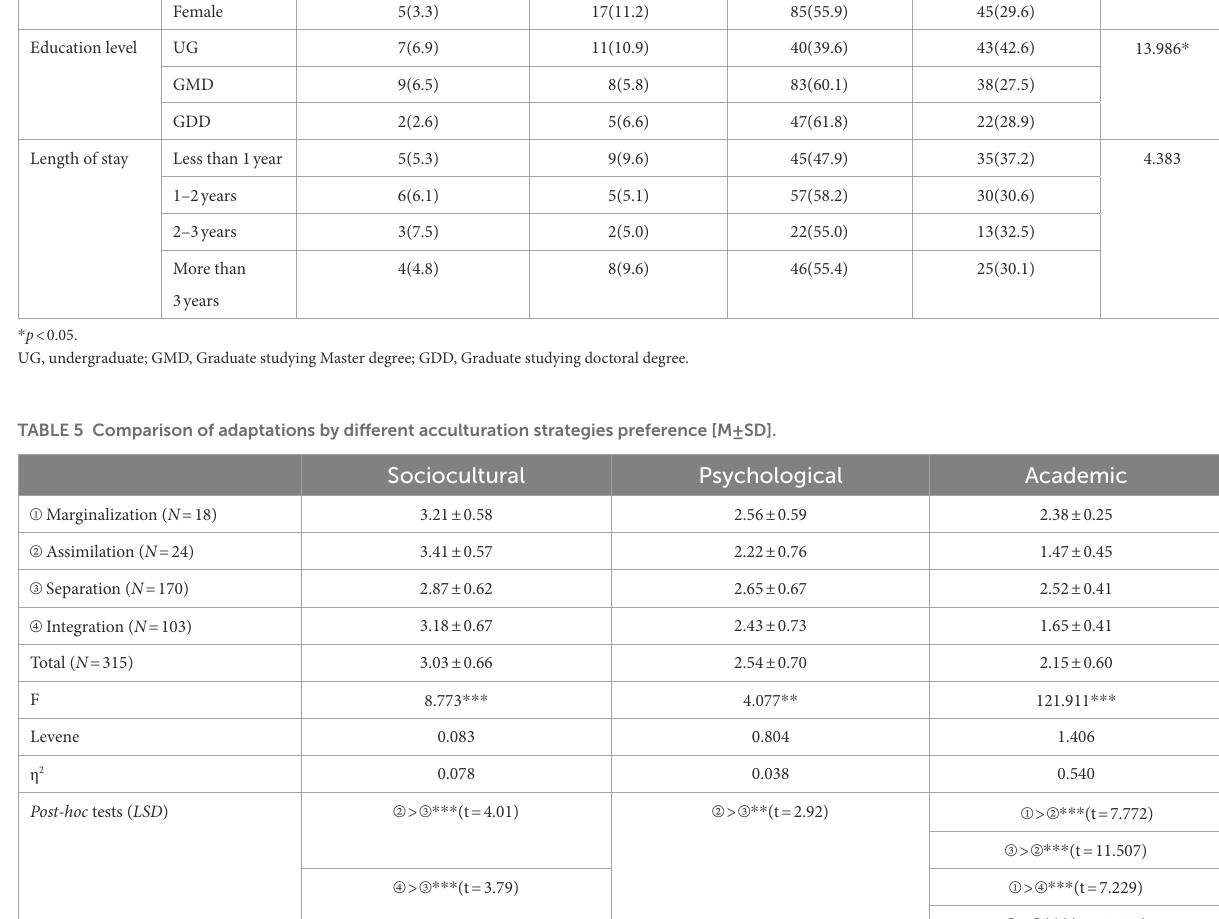
Table 6 indicates that academic adaptation cannot be predicted significantly by demographic variables. After controlling for demographic variables, students adopting